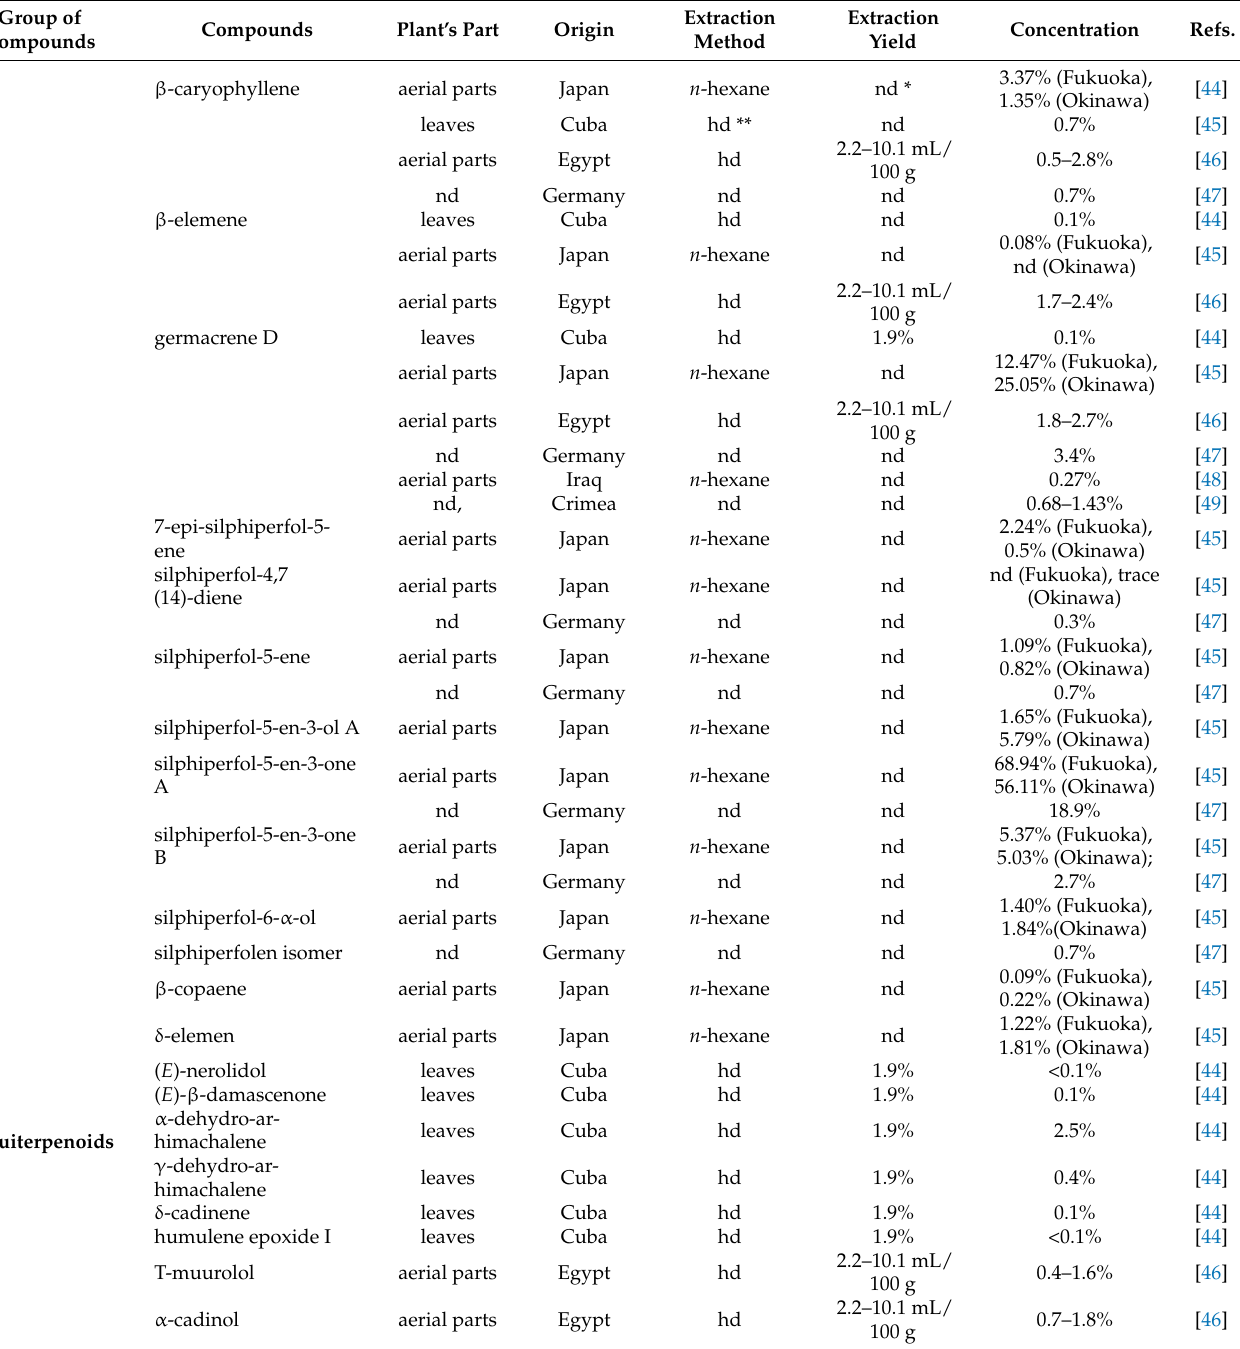
Table 1. Chemical composition of A. abrotanum essential